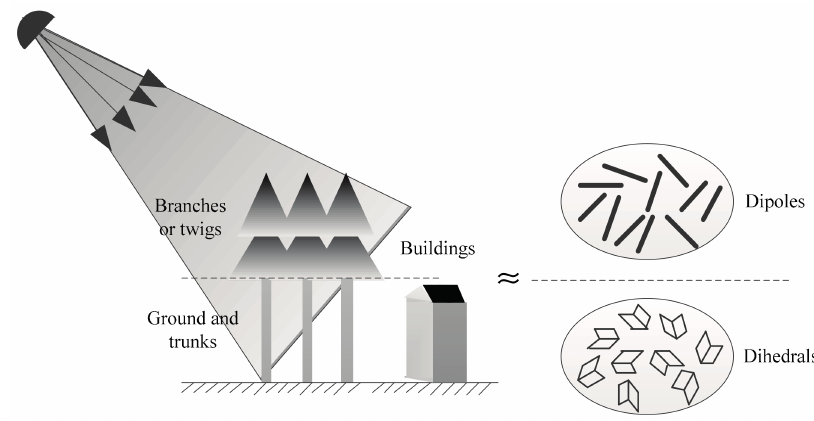
Figure 1. Division of the fourth